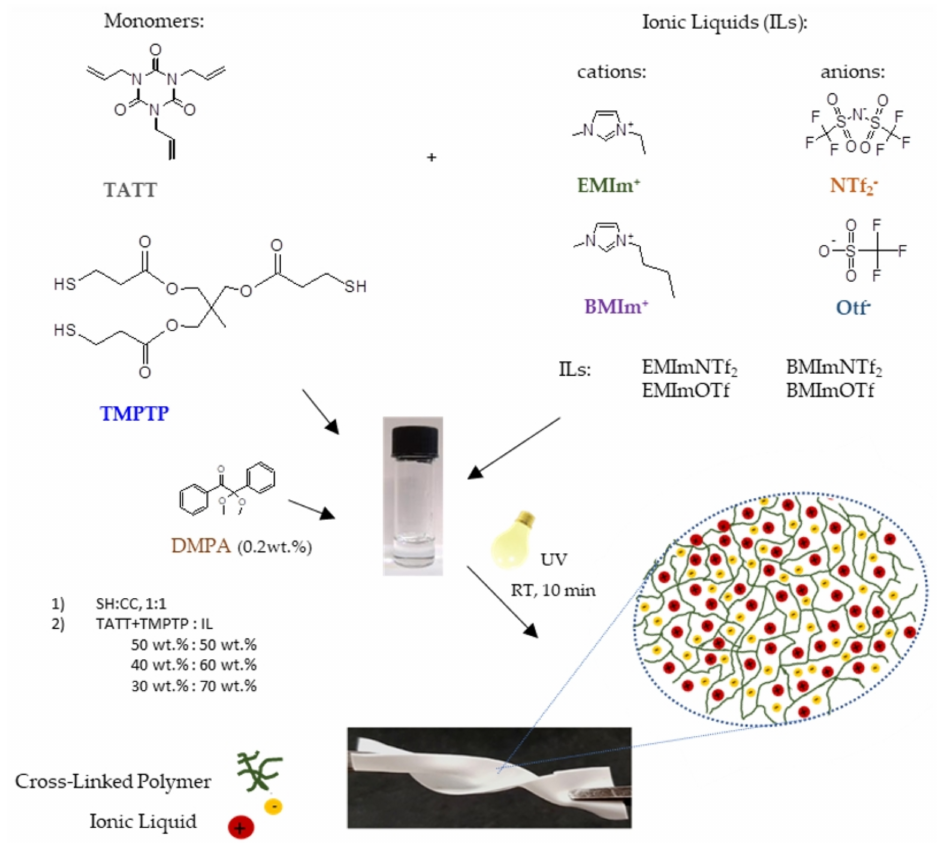
Figure 9. Schematic illustration of ionogels